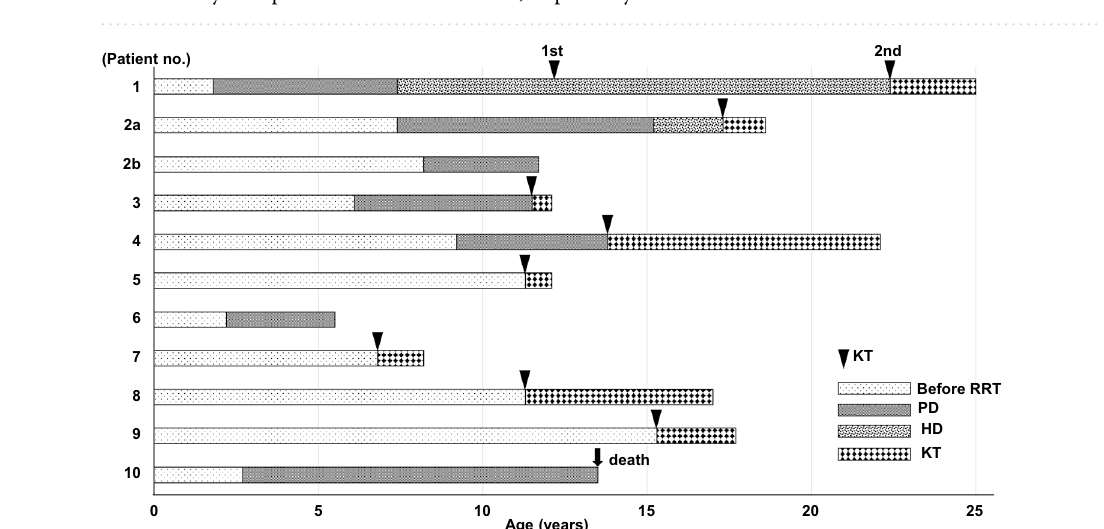
Figure 1. Age, height, and body weight at end-stage kidney disease in Joubert syndrome patients with profound and moderate/mild developmental delay. Age ( a ), height ( b ), and weight ( c ) at end-stage kidney disease are shown. Filled circles and filled squares denote patients who underwent peritoneal dialysis and preemptive living donor kidney transplantation as the initial RRT, respectively.